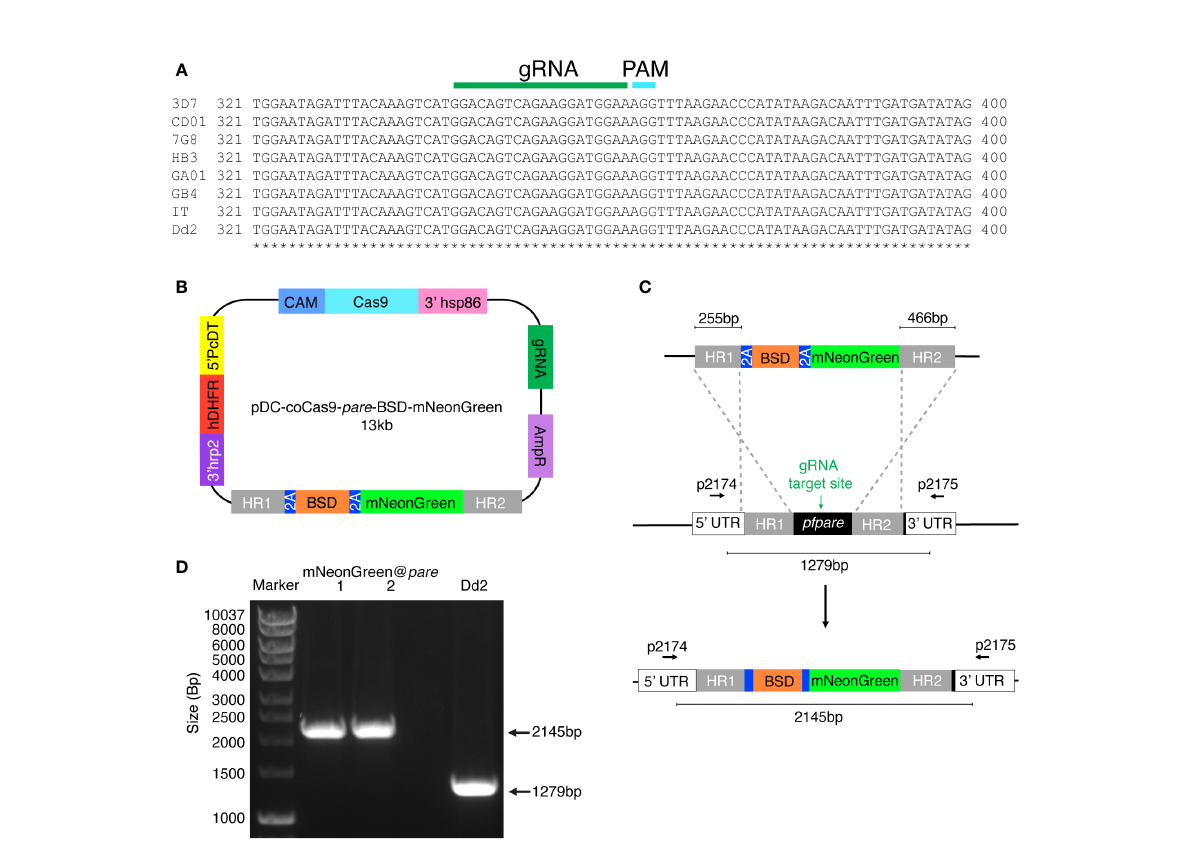
FIGURE 1 Generation of a P. falciparum Dd2 reporter line expressing mNeonGreen under the control of the highly conserved pfpare locus (mNeonGreen@ pare ). (A) DNA sequences for pfpare (PF3D7_0709700) in P. falciparum 3D7, HB3, 7G8, GB4, CD01, GA01, IT and Dd2 strains were obtained from PlasmoDB and Clustal Omega was used to create a multiple sequence alignment (Goujon et al., 2010; Sievers et al., 2011; Amos et al., 2021). (B) Schematic of the pDC2-coCas9- pare -BSD-mNeonGreen plasmid. The plasmid encodes a codon-optimised Cas9 enzyme, guide RNA cassette containing a guide targeting pfpare , an ampicillin resistance cassette for plasmid propagation in E coli and the hDHFR marker for selection for plasmid uptake in P. falciparum. The donor region contains a blasticidin S deaminase (BSD) selectable marker fl anked by 2A linkers with mNeonGreen downstream. The payload is fl anked by two homology regions for the pfpare locus. (C) Upon transfection of the pDC2-coCas9- pare -BSD-mNeonGreen plasmid into P. falciparum Dd2, the pfpare -targeting gRNA directs Cas9 to make a site-directed cut of pfpare . The donor region facilitates homology-directed repair and the insertion of BSD and mNeonGreen. (D) The pfpare locus of blasticidin-resistant recrudesced parasites (mNeonGreen@ pare .1 and mNeonGreen@ pare .2) was PCR-ampli fi ed using 5 ’ and 3 ’ UTR primers (p2174 and p2175) to check for correct insertion of mNeonGreen. Lengths of PCR products were quanti fi ed using gel electrophoresis. No detectable wild type product was observed in the transfected bulk